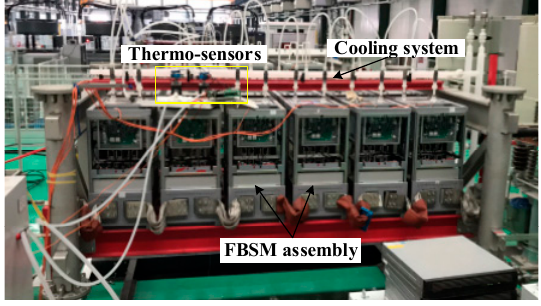
Figure 18. Front view of type test setup with thermos-sensors.